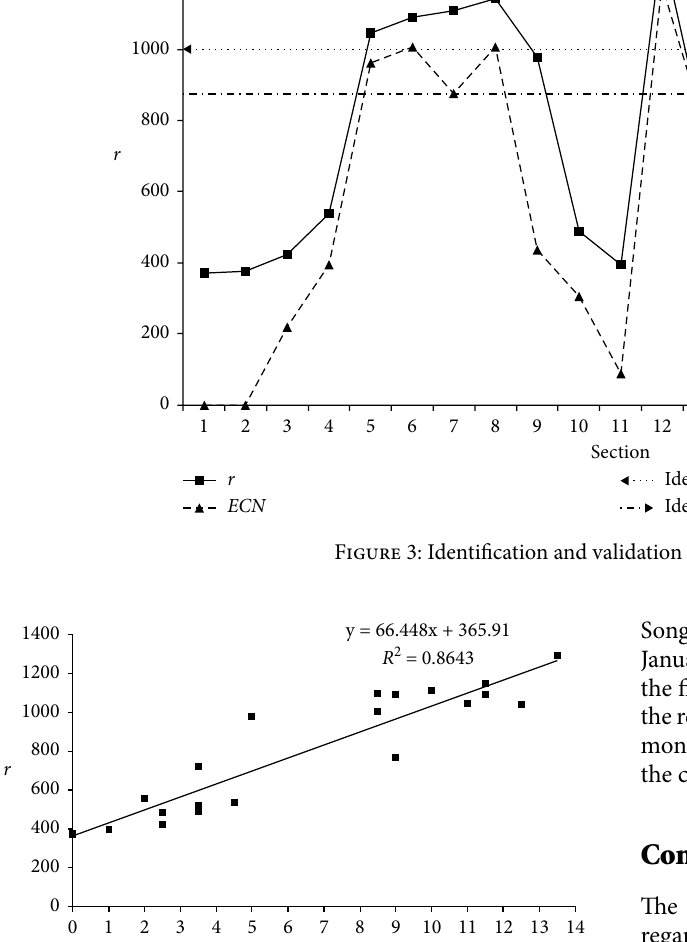
Figure 4: The relationships between the values of corresponding to the 21 research